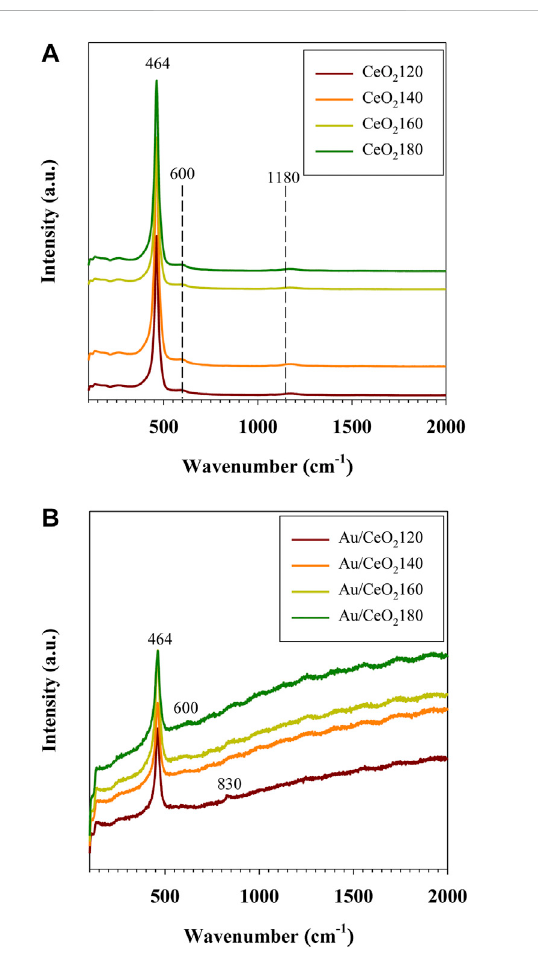
FIGURE 7 Representative Raman spectra of (A) CeO 2 X supports and (B) Au/CeO 2 Xcatalysts. CeO 2 X: cerium oxide obtained atavalueXfor the temperature of the preparatory hydrothermal process; Au/ CeO 2 X: CeO 2 X-supported gold